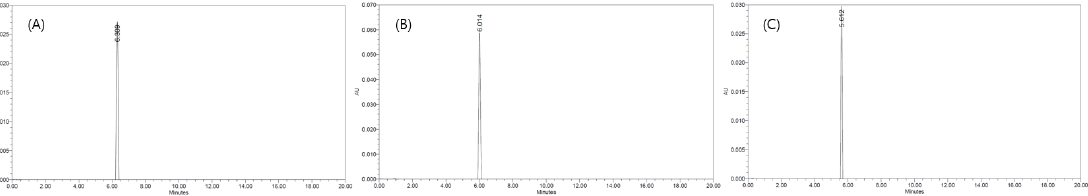
Table 1. The original sample preparation method and the modified sample preparation method.